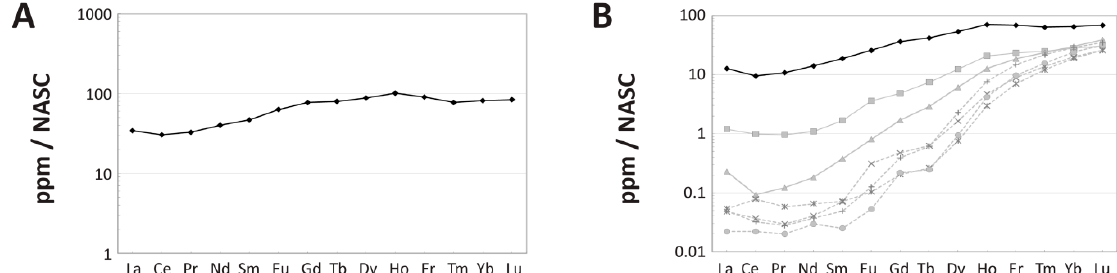
Figure 6. Spider diagrams of intra-bone NASC-normalized REE distribution patterns within the femur of MOR 1125. ( A ) Average composition of the outermost 250 µ m of the cortex, demonstrating a similar magnitude of relative LREE depletion in the outermost cortex as seen in the bone as a whole (Figure 5B). ( B ) Variation in compositional patterns by laser transects. The pattern which includes the external margin of the bone is shown in black, those from deepest within the bone by dotted, lightgray lines, and all other analyses in between by solid, darkgray lines.